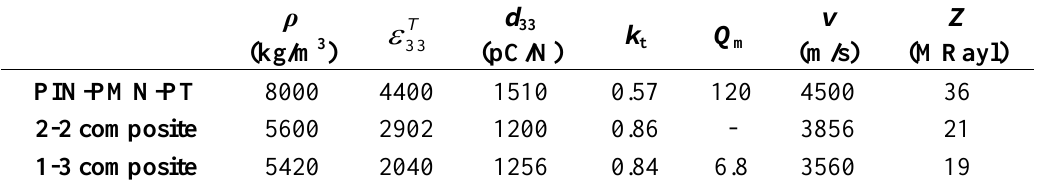
Table 4. Properties of the PIN-PMN-PT single crystal and its 2-2 and 1-3